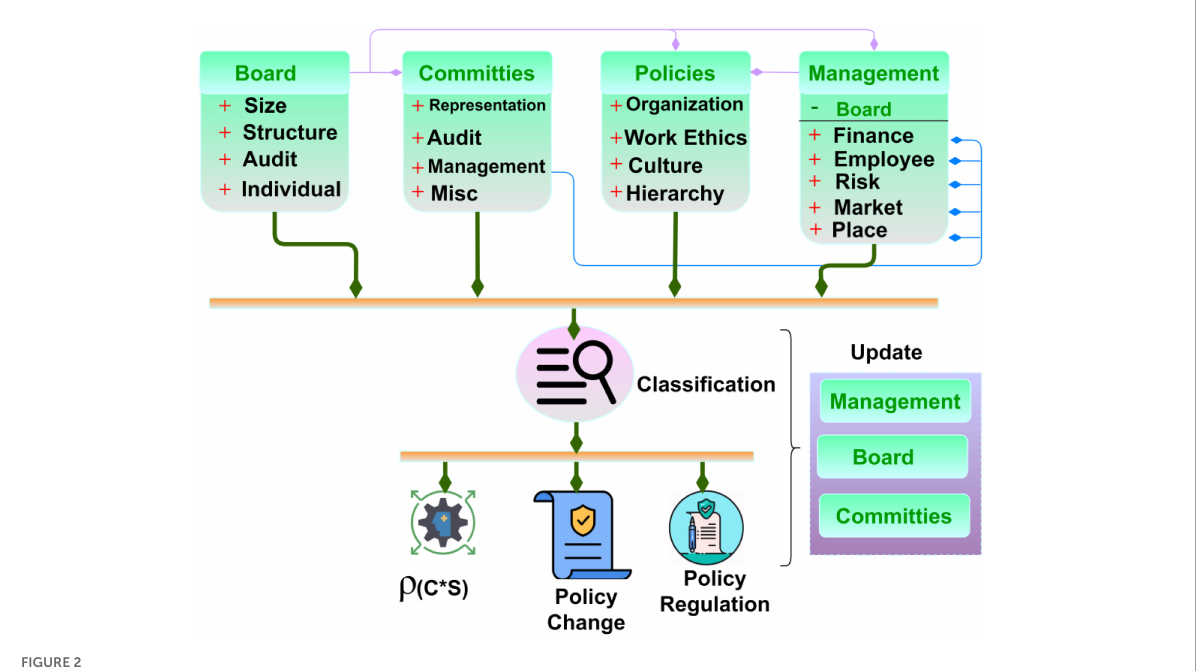
FIGURE2 Governance policies